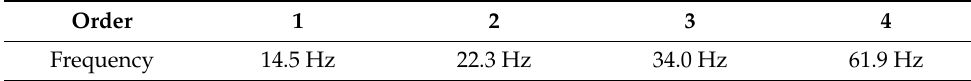
Table 1. The solution result of torsional vibration natural frequency.